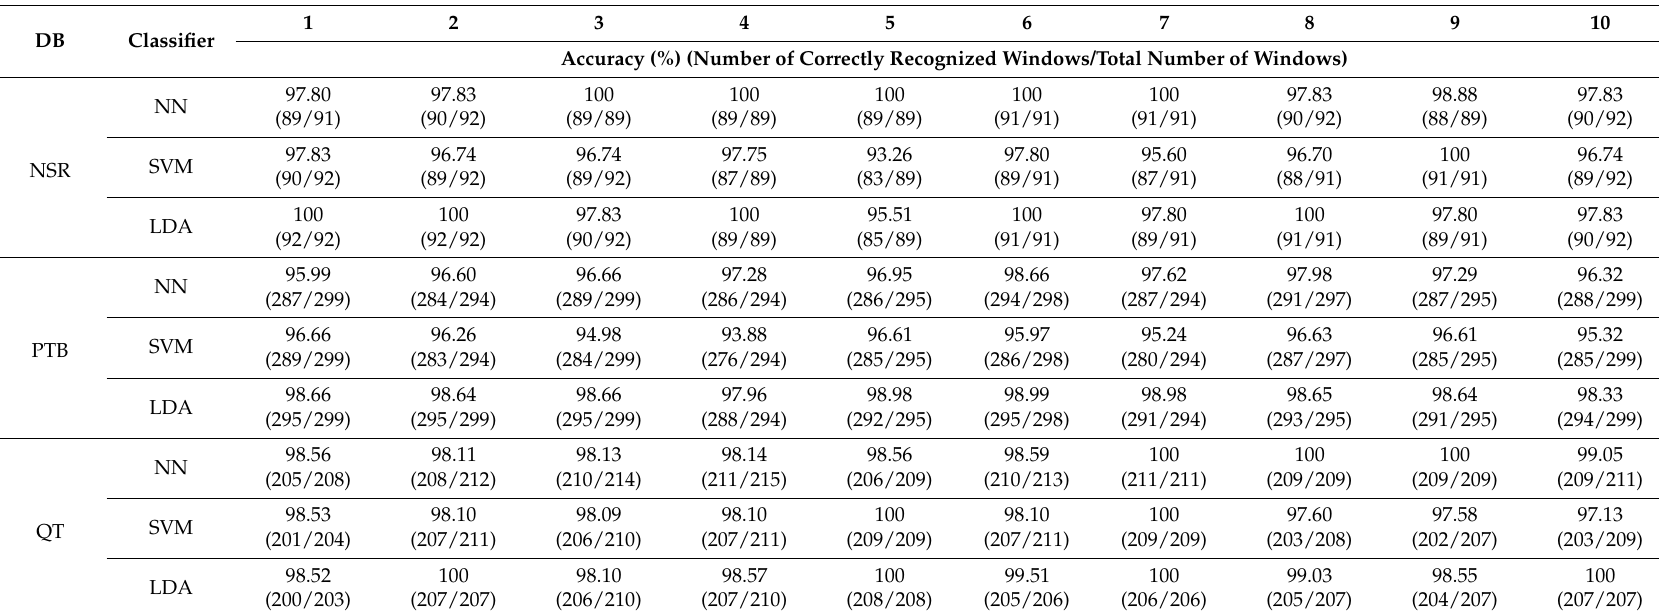
Table 7. Random selection